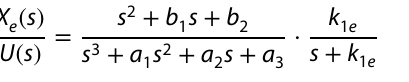
function:Symbol and unit Description